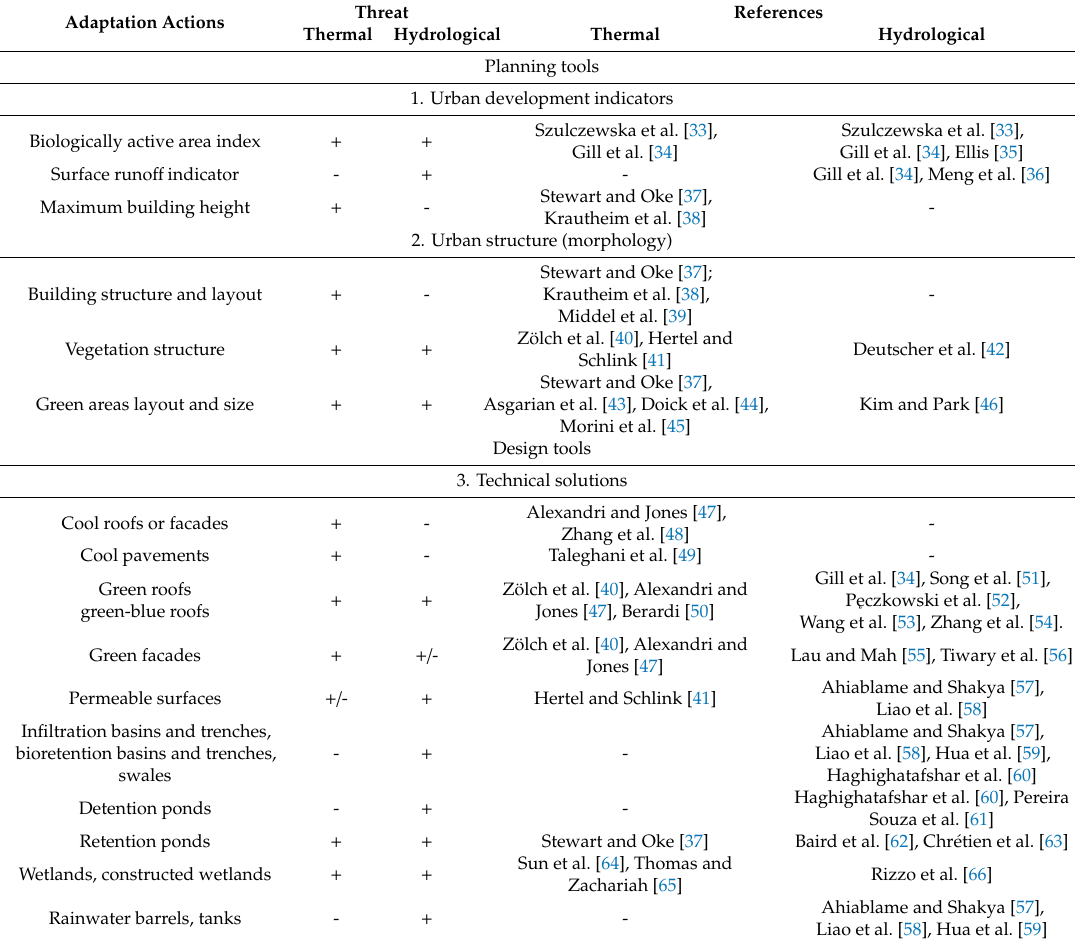
Table 1. Tools to build resilience at the planning and design level and its impact on climate